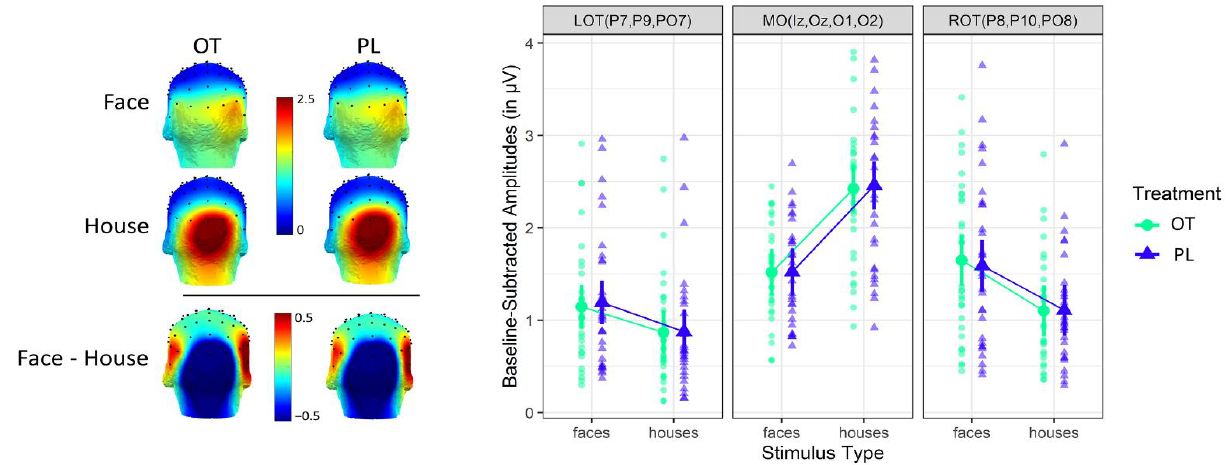
Figure 3. Left: scalp distribution of the EEG signal based on baseline-subtracted amplitudes in µ V. Right: grand-averaged baseline-subtracted amplitudes at each ROI for each stimulus type under each treatment condition. Statistical analysis showed a significant interaction between stimulus type and ROI. Table 1. Results of LMM analyses on neural responses with treatment condition (OT, PL), stimulus type (face, house) and ROI (LOT, ROT, MO) as fixed effects and session order (OT session first, PL session first) as nuisance